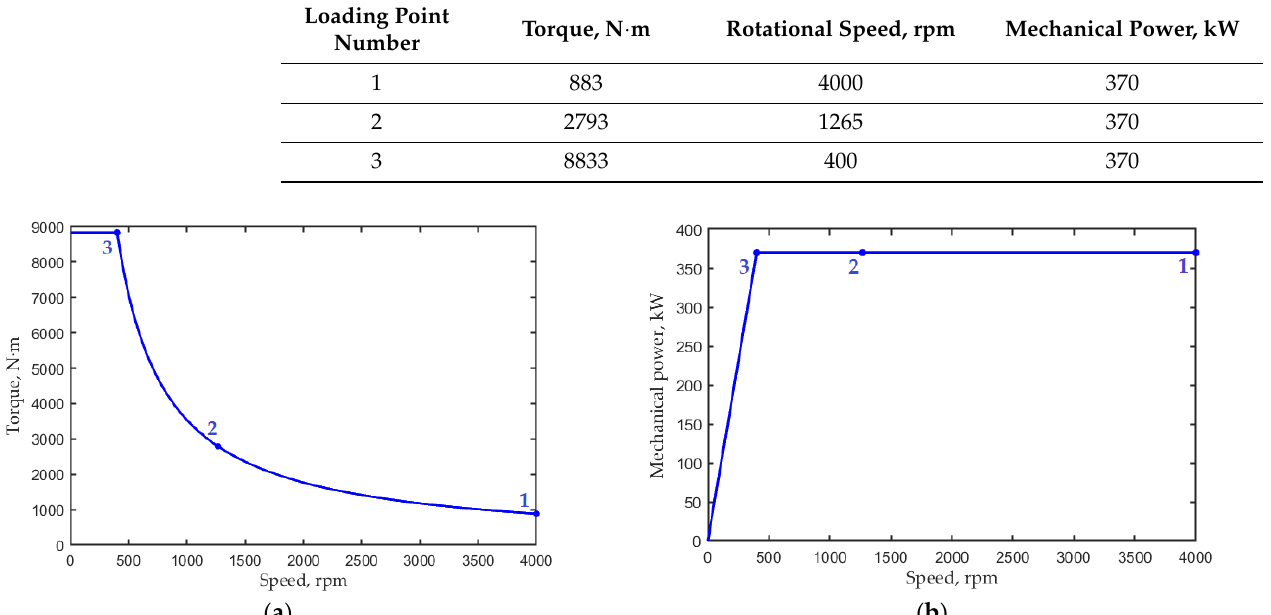
Figure 4. Requirements for the characteristics of the considered traction electric drive: ( a ) torque versus speed curve; ( b ) output mechanical power versus speed curve. The numbers 1,2 and 3 indicate the numbers of operating points, according to Table 1. Table 1. Operating points of the traction motor considered during optimization.